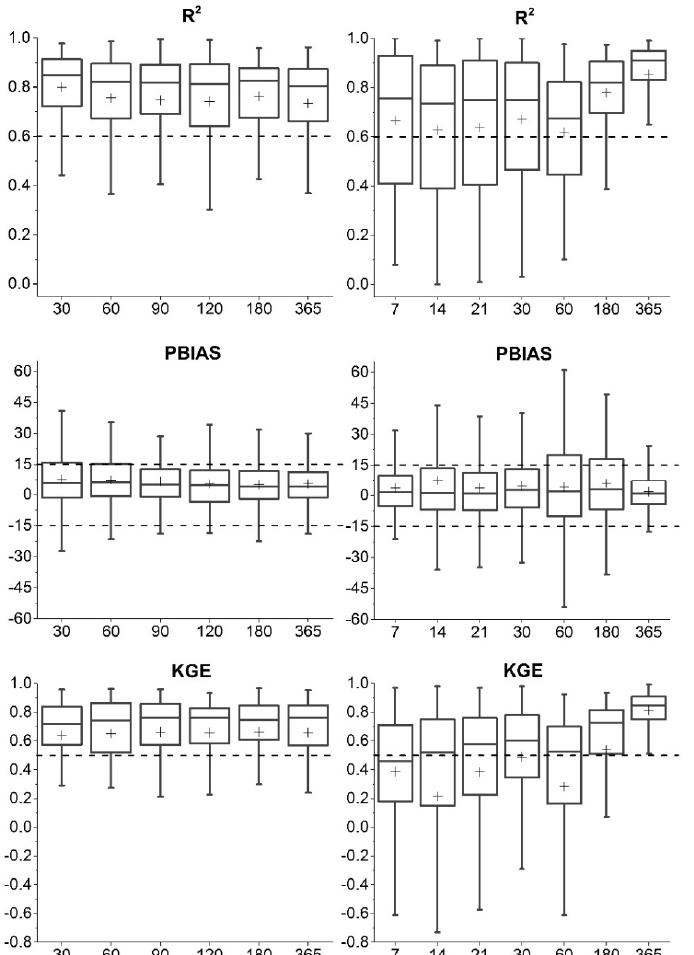
Figure 5. Validation of the RF method of filling the gaps in daily flow series, as determined through R 2 , percent bias (PBIAS), and Kling-Gupta efficiency (KGE). The left column shows the results for the random gaps and the right column shows the results for random continuous gaps. The crosses indicate the mean value and the dashed lines represent the recommend value.